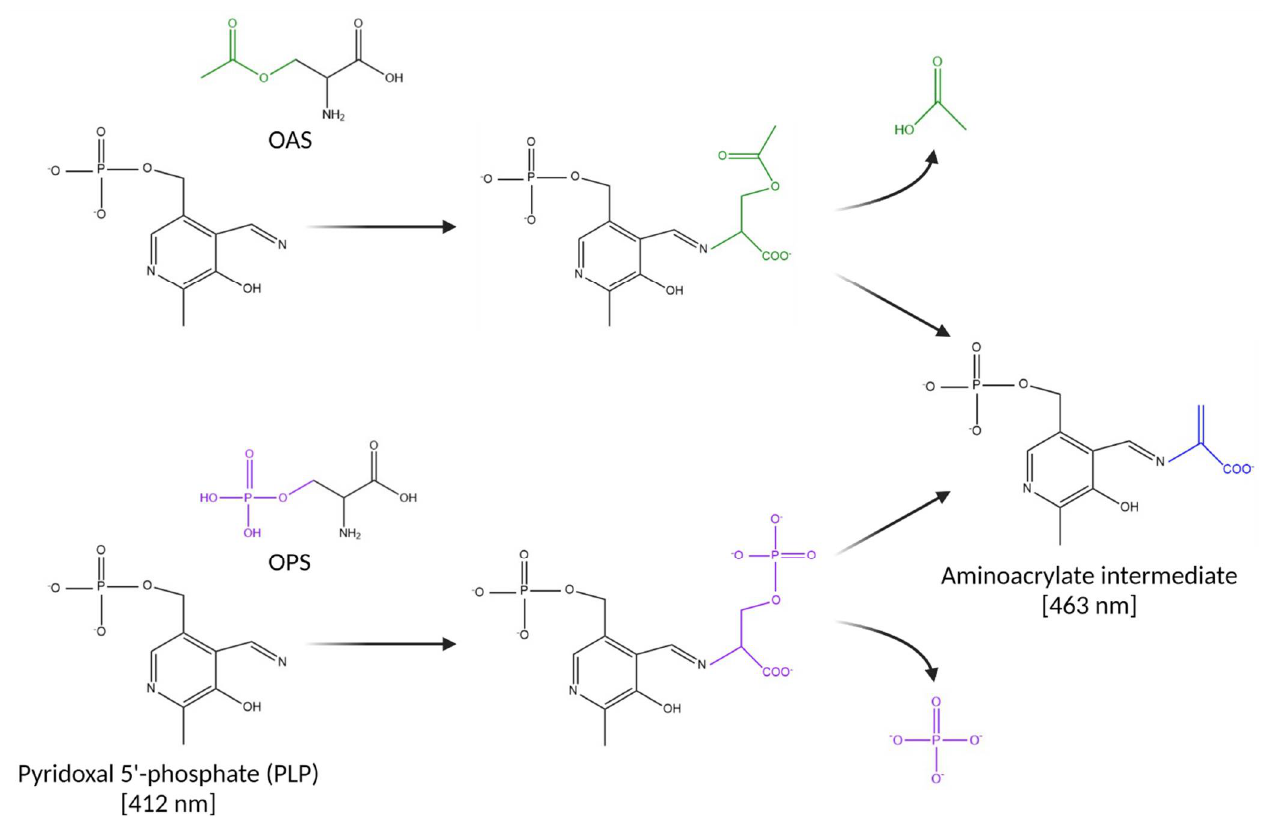
Figure 1. First half-reaction of PLP-dependent cysteine synthase. The enzyme bound PLP cofactor forms an internal Schiff base with a catalytic lysine residue which transfers to the sulfur acceptor (either OAS or OPS) to form an intermediate which subsequently releases acetate or phosphate (for OAS and OPS, respectively) through a β-elimination event. Subsequent proton extraction from the α position by the catalytic lysine resolves the covalently bound α-aminoacrylate intermediate form. Resting PLP and the aminoacrylate intermediate can be differentiated spectrophotometrically by their respective absorbance maximum of 412 and 463 nm.